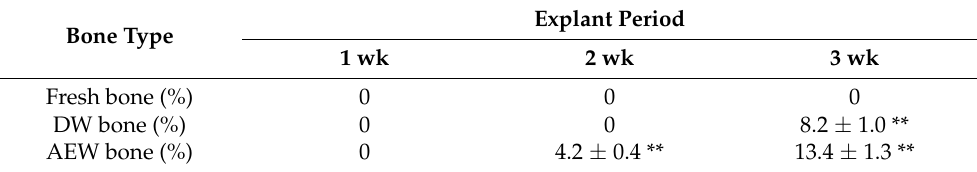
Table 2. Histomorphometric analysis of induced bone at 1, 2, and 3 weeks. Bone